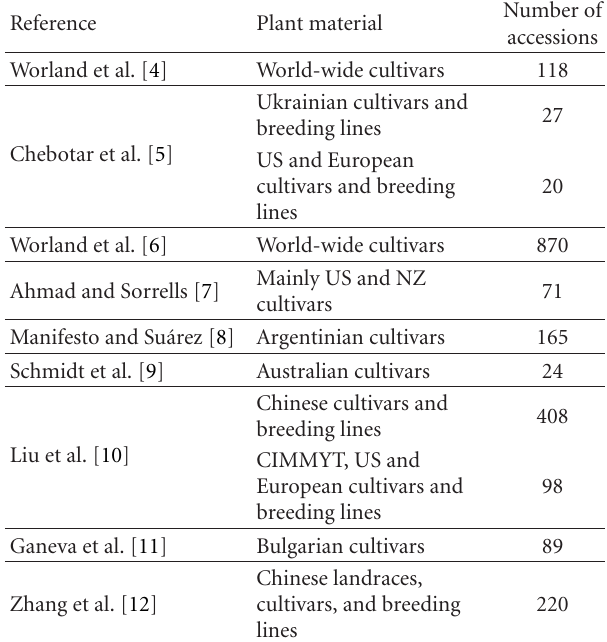
Table 1: Studies of WMS261 allelic